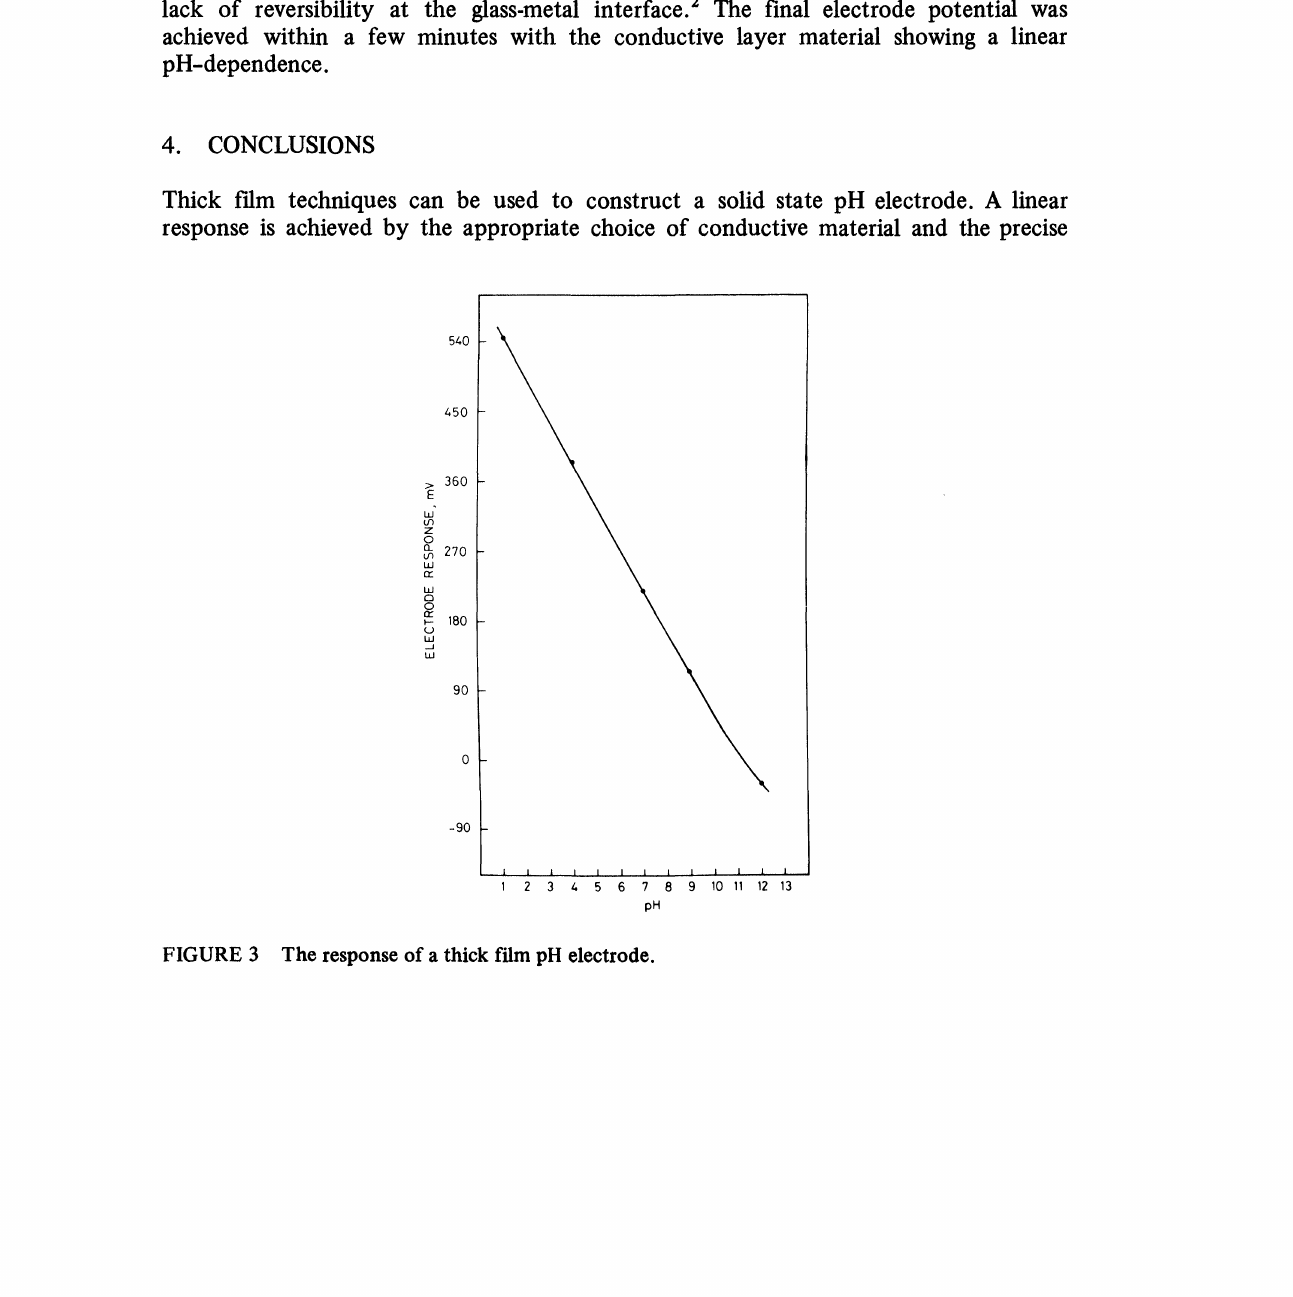
FIGURE 3 The response of a thick film pH